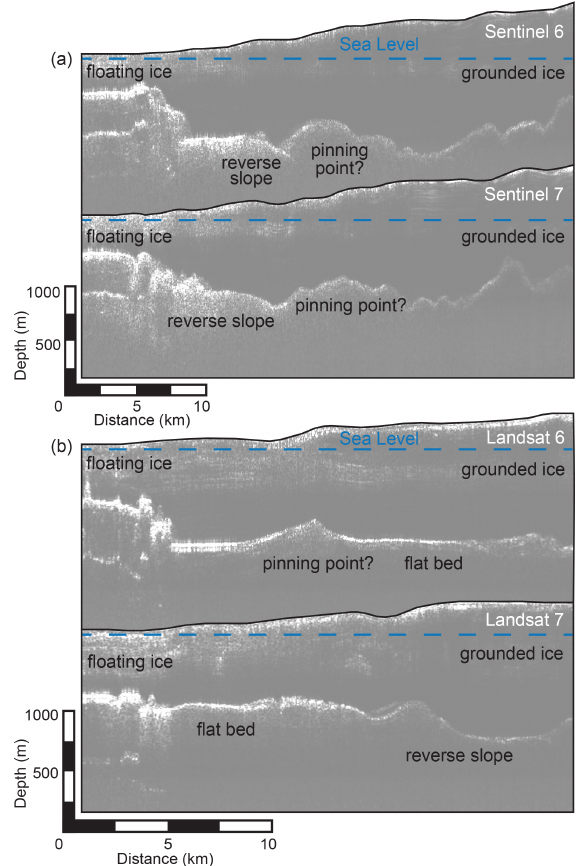
Figure 7. Along-flow radar transects of Sentinel Ice Stream (a) and Landsat Ice Stream (b) . Transect locations are marked by circles in Figs. 4c and 6a. All four radargrams reveal a general pattern of sur- face lowering and ice sheet thinning down-flow (from right to left). Bright, white, diffuse reflectors on the left-hand side of the radar- grams represent floating ice and water ingress. Annotations high- light these features and basal conditions. Sea level is marked by a blue dashed